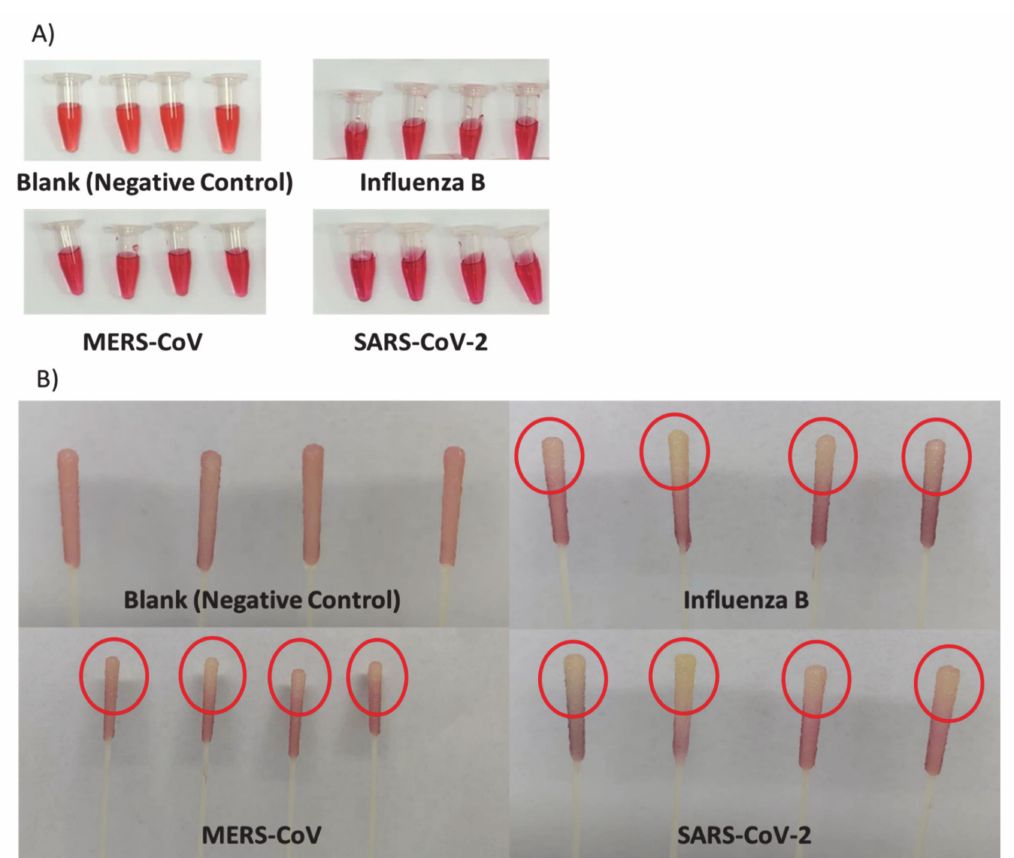
Figure 6. Positive swab samples of influenza B, Middle-East respiratory syndrome (MERS), and SARS-CoV-2 were immersed in SA-Au NPs for 20 min compared to the blank swabs. ( A ) An evident color change in the NPs solution in all viral-loaded swabs compared to the blank swabs; ( B ) Yellowish-white tips of all viral-loaded swabs compared to the tips of the blank swabs, which shown in